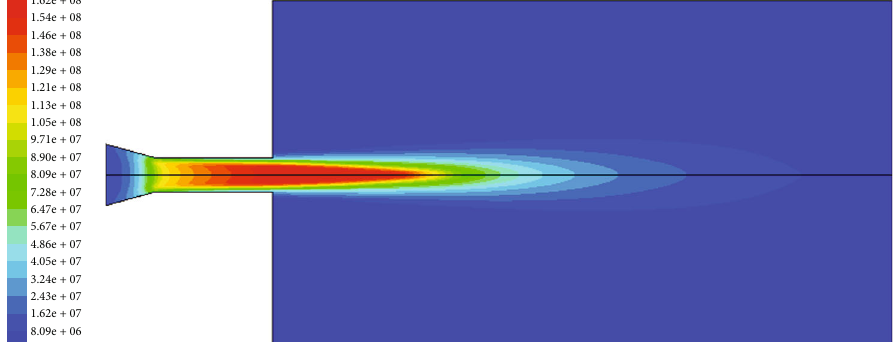
Figure 3: Dynamic pressure distribution of the water jet